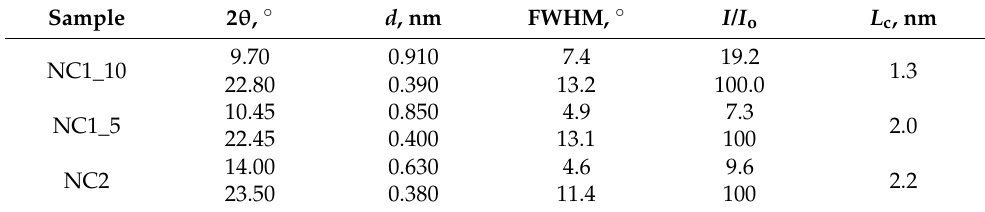
Figure 6. Analysis of the diffuse peak profile of the carbon phase in NC1_10 ( a ); NC1_5 ( b ); NC2 ( c ) samples. Table 1. Parameters of carbon phase peaks in synthesized nanocomposites.